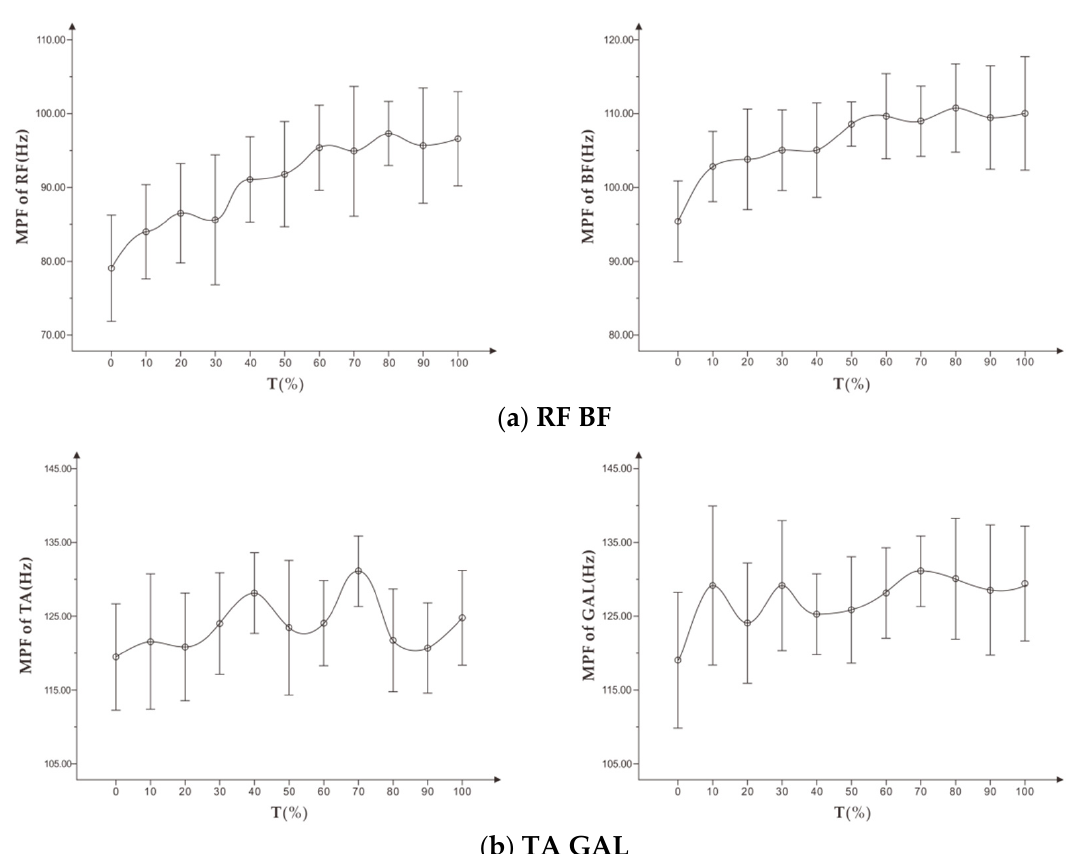
Figure 8. ( a ) shows the trend of MPF (x ± s) on RF, BF, and ( b ) shows the trend of MPF (x ± s) on TA, GAL in standardized time in the constant load experiment.